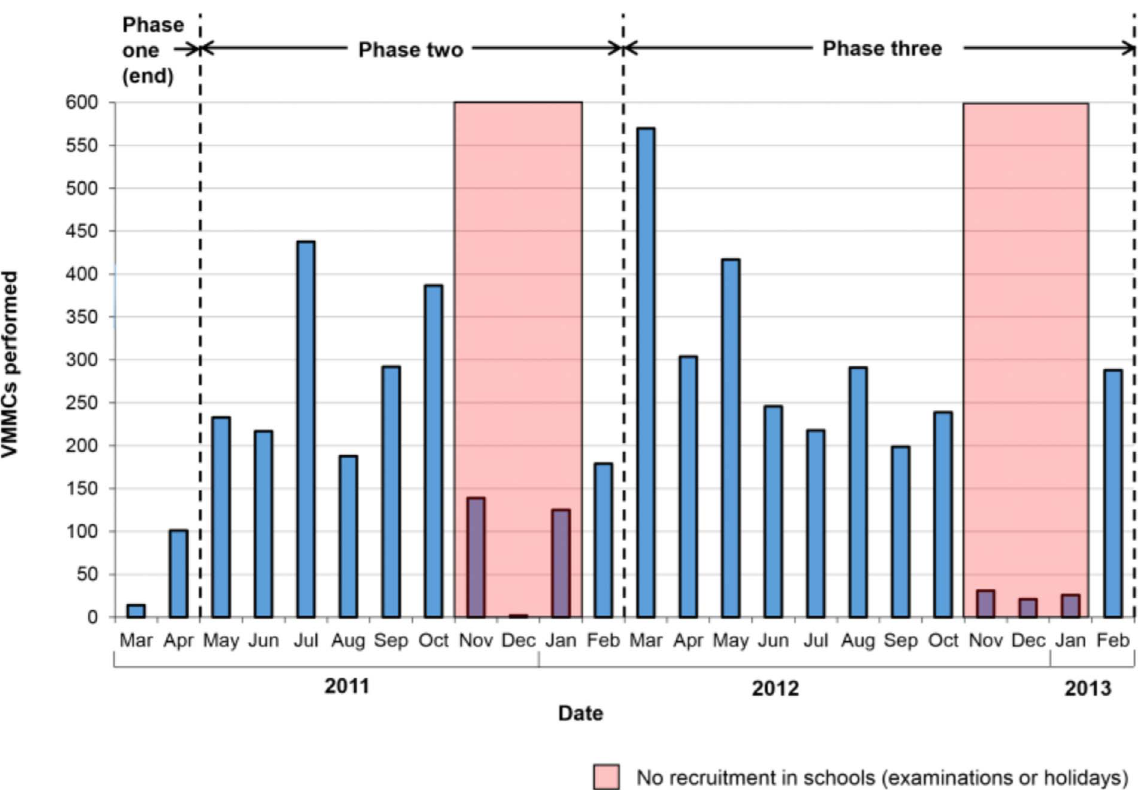
Figure 2. VMMCs performed by the CAPRISA VMMC program between March 2011 and February 2013. VMMCs performed by the CAPRISA clinic per month shown. No recruitment was undertaken in schools in November and December at the request of school officials to avoid disruption to examinations; recruitment was also not undertaken in the school holidays in January. Phase 1 of demand creation (community consultation) began in June 2010 and continued until April 2011. Phase 2 of demand creation (in-school information dissemination) was initiated from May 2011 to the end of February 2012. Phase 3 of demand creation (peer recruitment) began in March 2012 and continued until the February